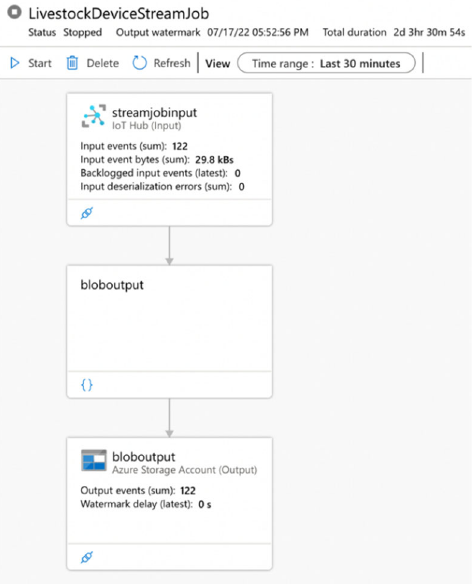
Figure 8. Data pipeline—from IoT Hub through Stream Analytic Job to Blob Storage.